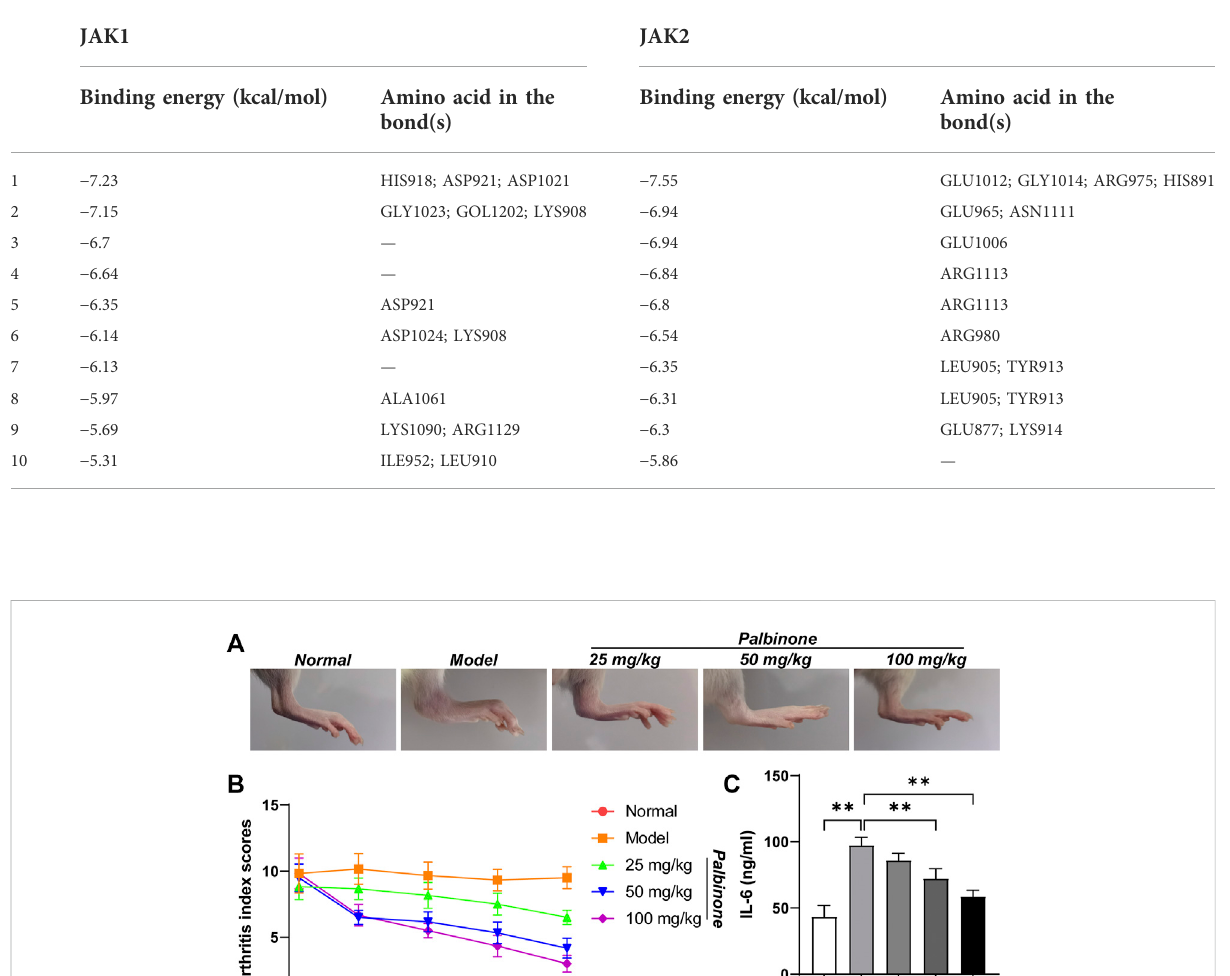
TABLE 2 The binding energy and sites of JAK1 and JAK2 with Palbinone ranked by binding energy from Autodock.